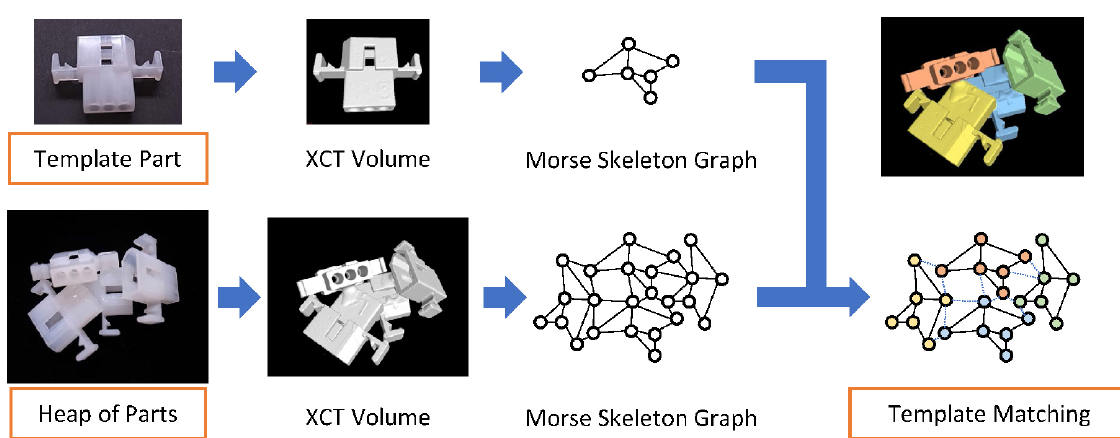
Fig. 2 An overview of our graph-based template matching system for bin-scanning. Our system processes two input volumes of a template part and a heap of parts identical to the template. The system identifies the region of each part in the volume of heaped parts and calculates the posture of the part as a rigid transformation matrix. To this end, each volume (i.e., those of a template part and its heap) is converted to a graph, which we refer to as a Morse skeleton graph. Then, using a subgraph matching technique, we match the graph of a template with subgraphs in the entire graph of heaped parts. Note that the graph structures in this figure are for illustration